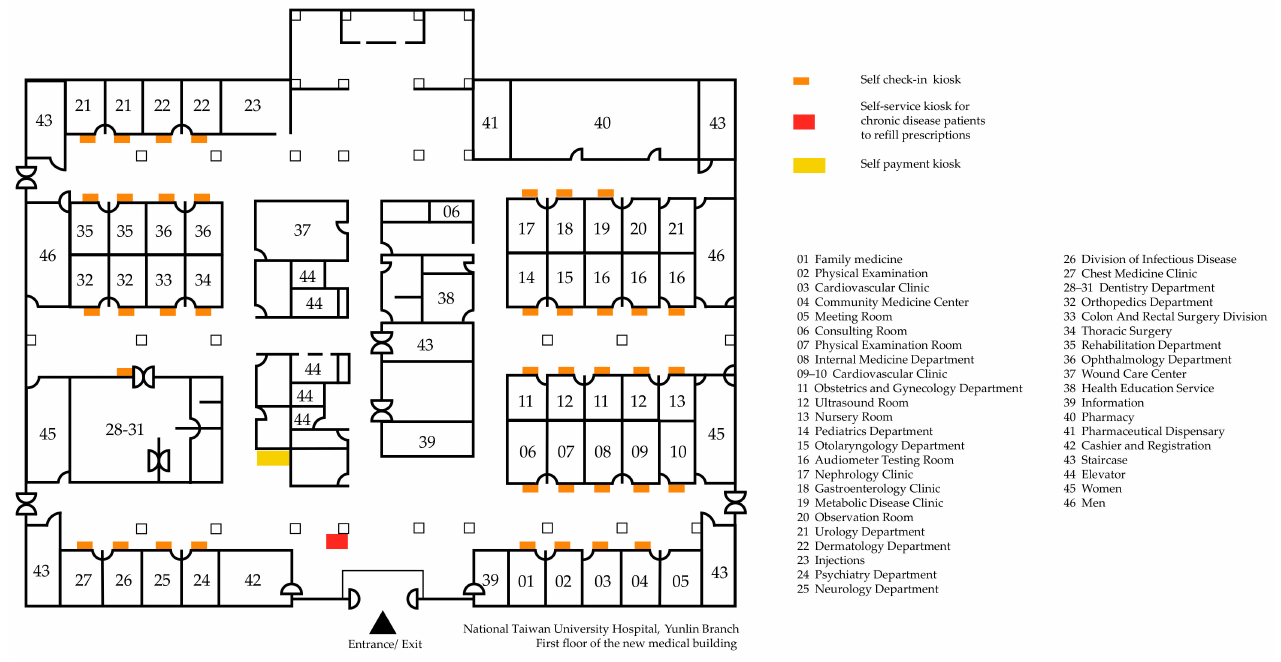
Figure 4. Hospital outpatient clinic floor